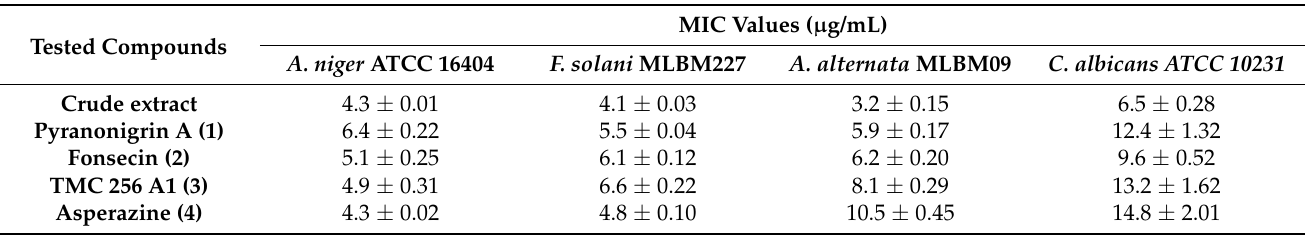
Table 1. MIC values of fungal crude extract and its isolated compounds of A. tubingensis (NA103) against selected pathogenic fungi.